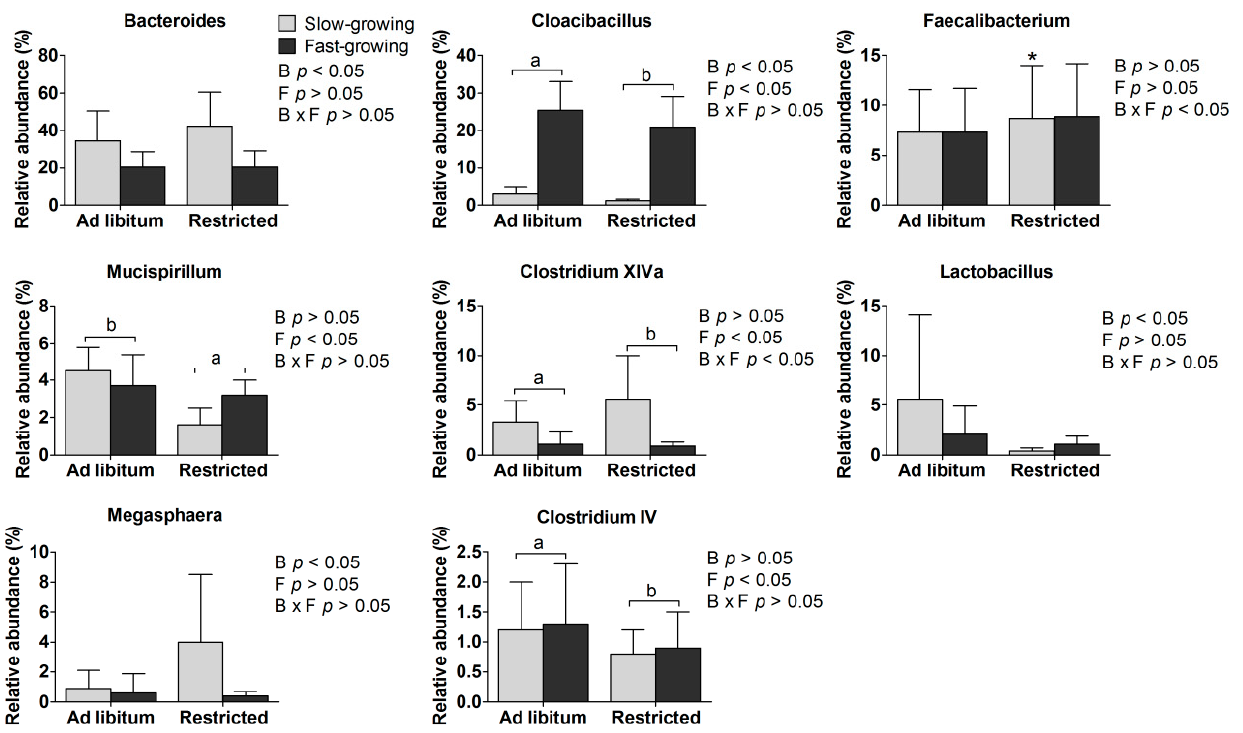
Figure 4. The relative abundance of the significant abundant cecal microbiomes at the genus level. a, b represent the significant difference between the ad libitum and feed restricted treatments ( p < 0.05). * means significant difference in the ad libitum or feed restricted treatments between slow- and fast-growing chickens ( p < 0.05). B: breed, F: feeding method, B × F: interaction between breed and feeding method.